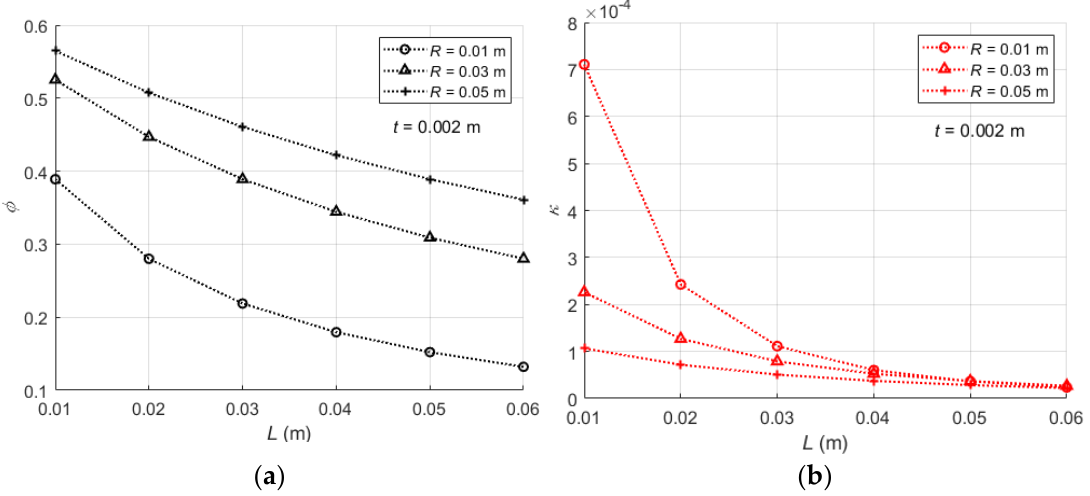
Figure 5. Effect of the corrugation shape on the nondimensional indexes: ( a ) ϕ , ( b ) κ . For a flexible corrugated panel, it is expected that the actuation force is limited when